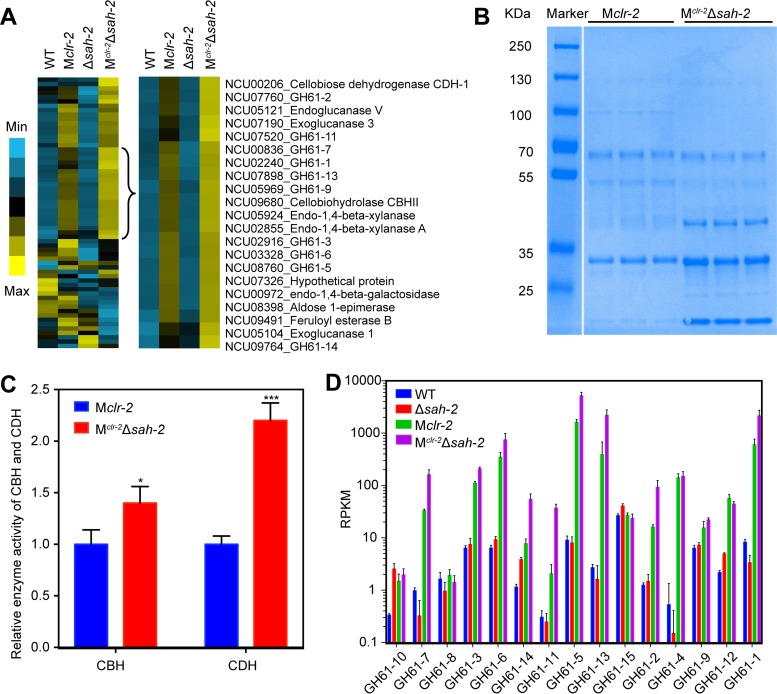
Strains bearing a deletion of sah-2 show increased expression of genes encoding LPMOs. (A) Hierarchical clustering of genes encoding extracellular proteins. Results are displayed as heat maps with log numbers of RPKM ranging from minimum (bright blue) to maximum (bright yellow). Genes with a higher expression level in the Mclr-2 Δsah-2 strain than in the Mclr-2 strain are highlighted at the right. (B) SDS-PAGE analysis of the supernatants of the Mclr-2 and Mclr-2 Δsah-2 strains from three independent 16-h cultures shifted for 48 h to VMM. (C) Measurement of the total CBH-1 and CDH-1 enzyme activities in the supernatant of Mclr-2 and Mclr-2 Δsah-2 after 48 h of growth in VMM. (D) The expression levels (RPKM) of 15 currently identified N. crassa LPMO-encoding genes in the WT, Mclr-2, the Δsah-2 mutant, and Mclr-2 Δsah-2. Asterisks indicate significant differences (*, P < 0.05; ***, P < 0.001).